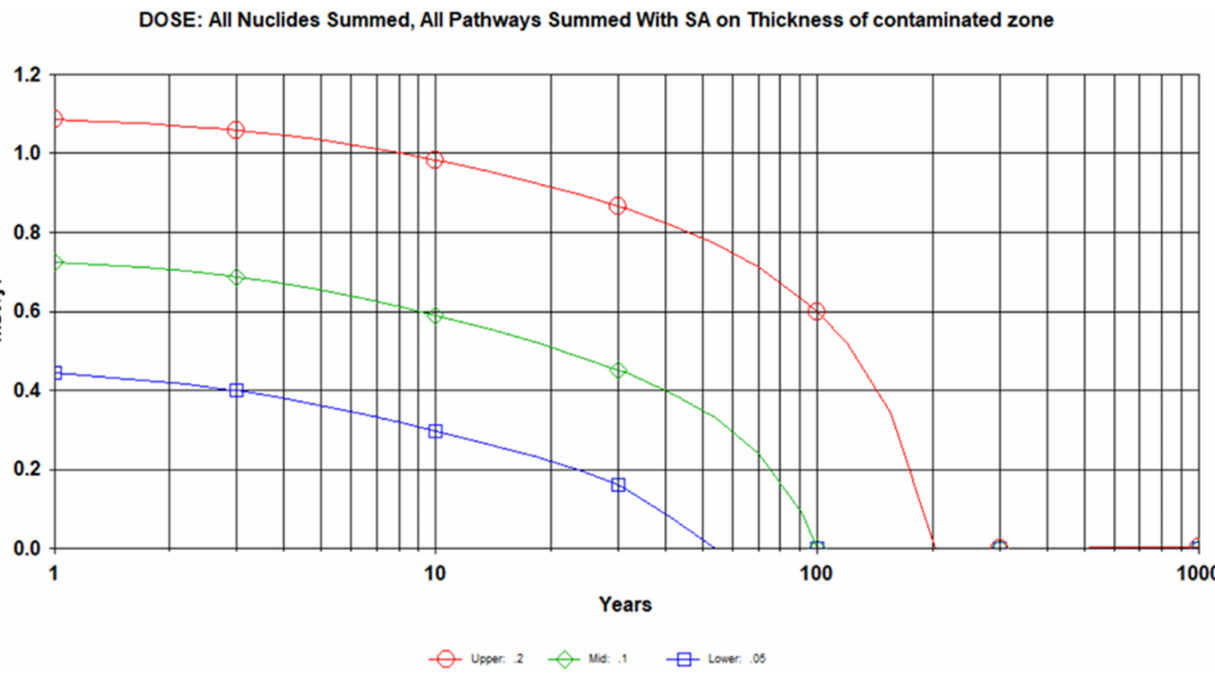
Figure 7. Total dose versus time for all radionuclides summed and all exposure pathways summed taking into account the sensitivity analysis on the thickness of the contaminated